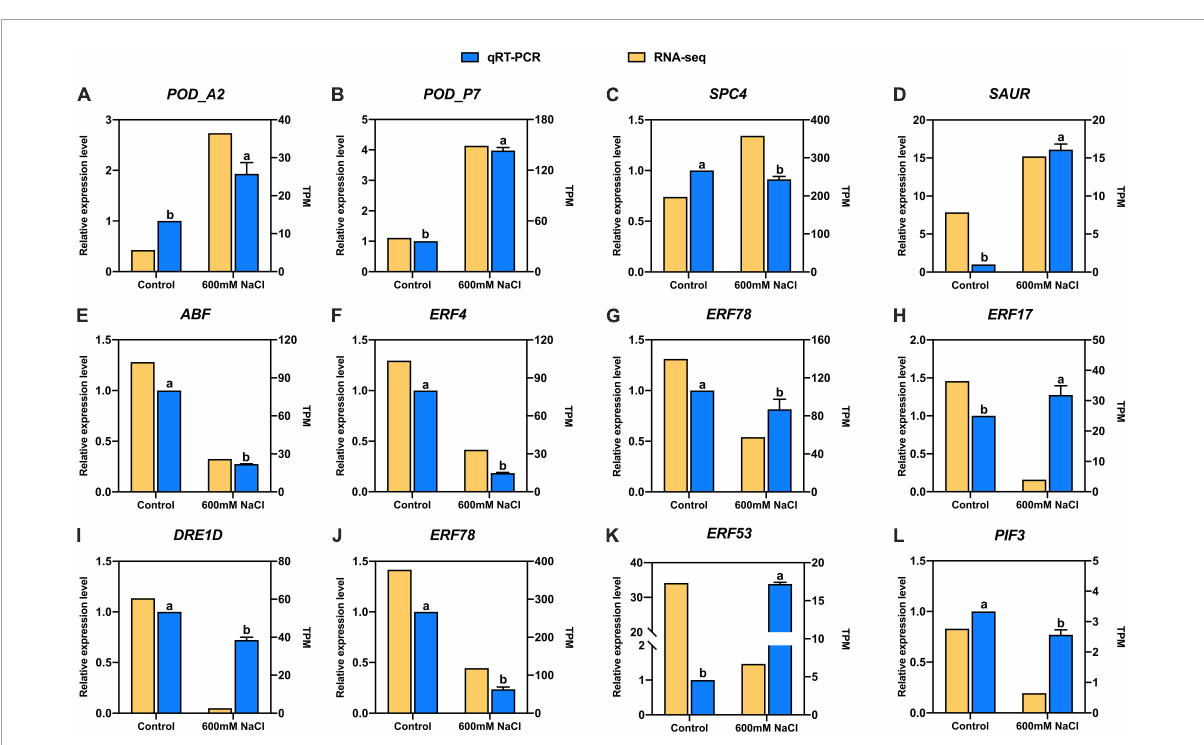
FIGURE7 Expression pattern validation of 12 selected DEGs in S. portulacastrum determined by RNA-seq and qRT-PCR. (A) POD_A2, (B) POD_P7, (C) SPC4, (D) SAUR, (E) ABF, (F) ERF4, (G) ERF78, (H) ERF17, (I) DRE1D, (J) ERF78, (K) ERF53, and (L) PIF3.Values are means ± SD ( n = 3). Values with a different letter within a sampling date are significantly different ( P <